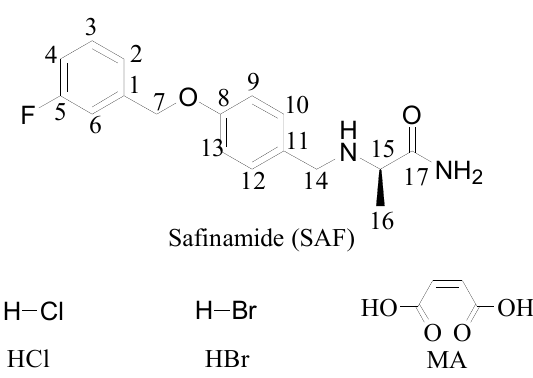
Figure 1. Chemical structures of safinamide and coformers.